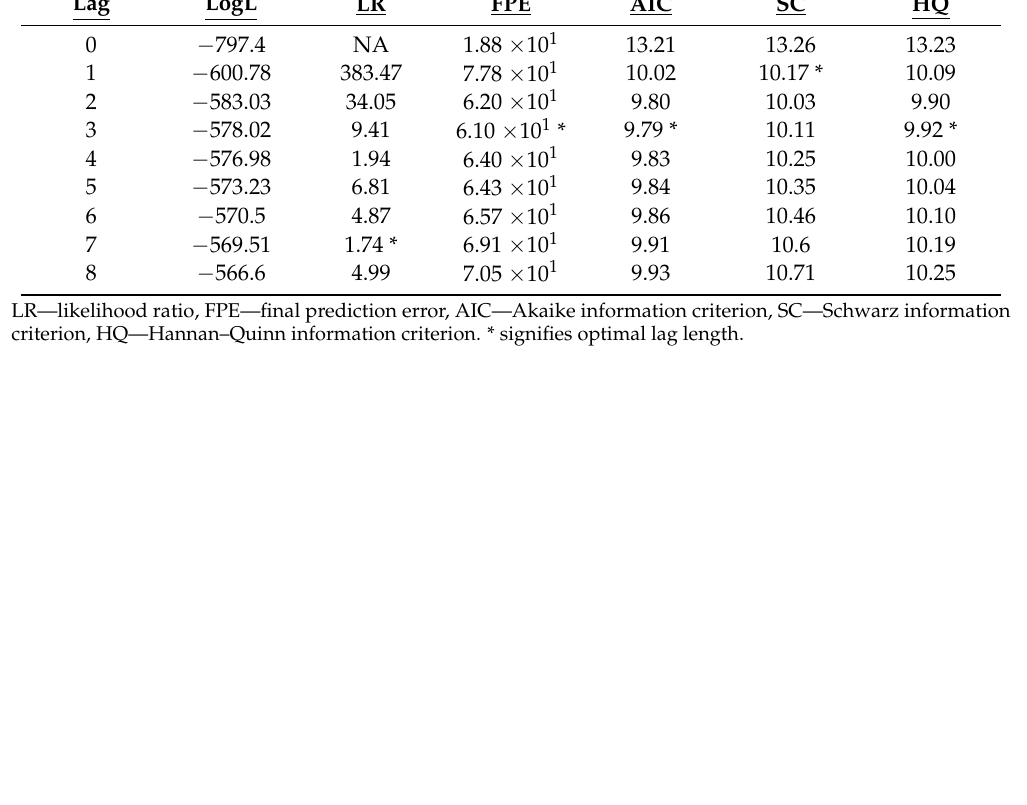
Table A2. VAR lag order selection criteria. Endogenous variables: oil price and exchange rate. Lag LogL